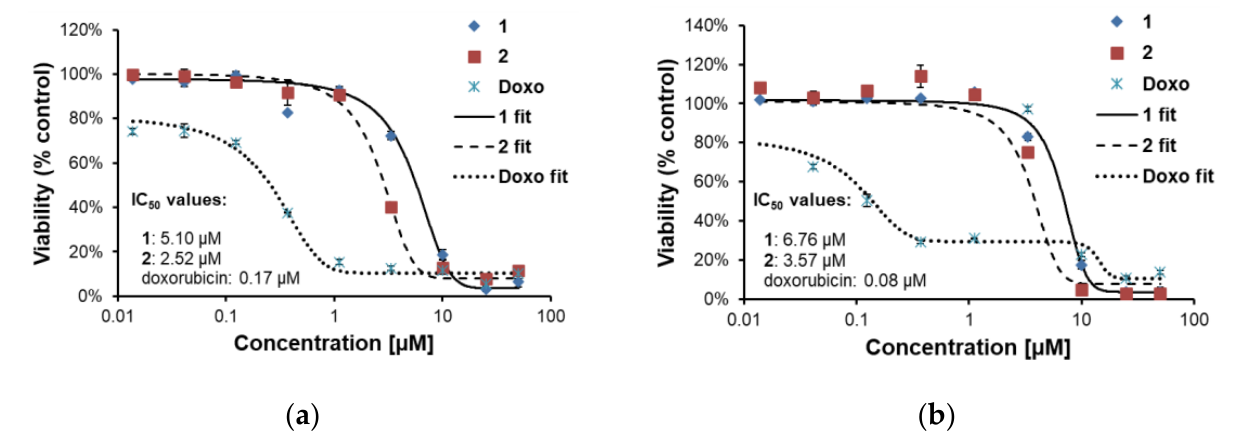
Figure 3. Viabilities of osteosarcoma cell lines U-2 OS (wild-type p53 status) and SAOS-2 (with p53 deletion) after 48 h treatment with 1 , 2 and doxorubicin (Doxo): ( a ) U-2 OS cells; ( b ) SAOS-2 cells.